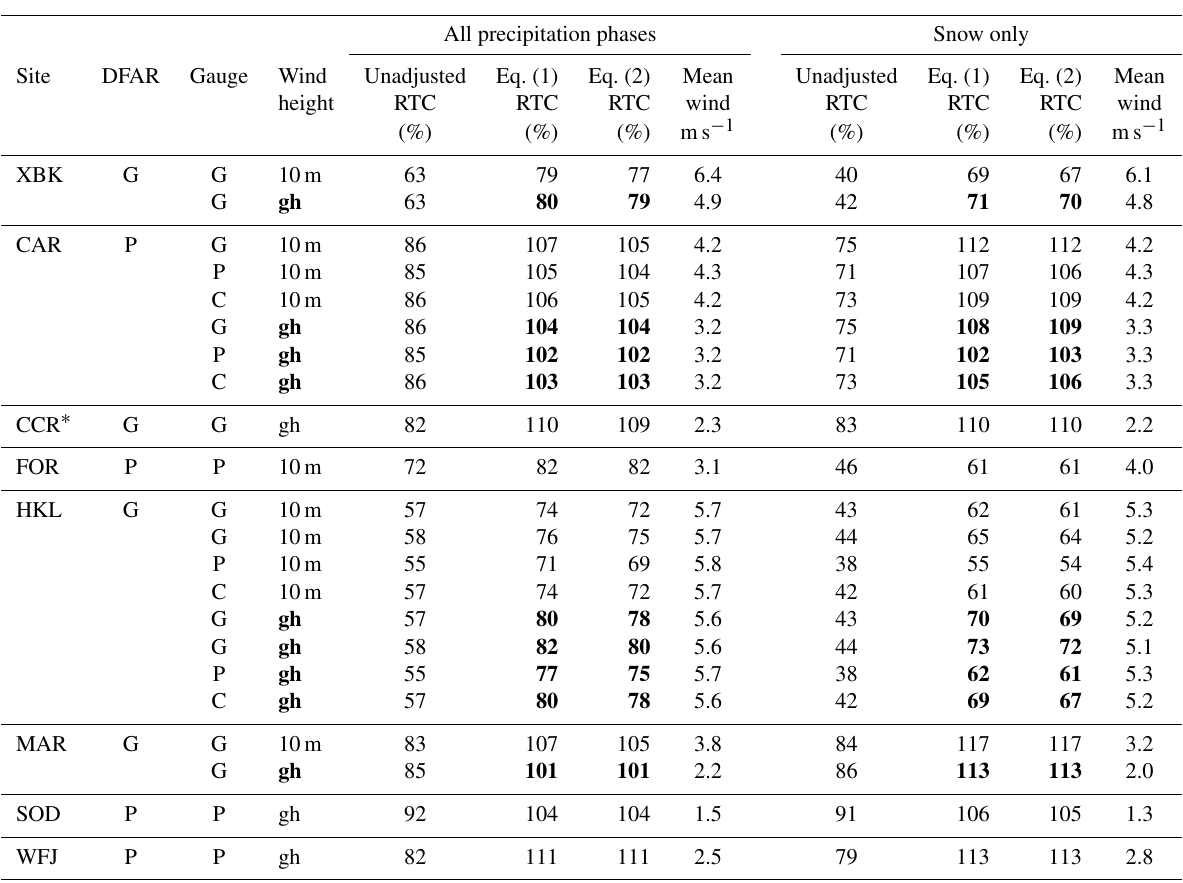
Table 2. Relative total catch (RTC) for the single Alter-shielded gauges (G – Geonor; P – Pluvio 2 ) as compared to the DFAR reference at each site for the combined winters of 2015/2016 and 2016/2017. Results are provided for available wind speed measurement heights (10m; gh – gauge height) and for Eqs. (1) and (2). Metrics are separated by precipitation phase (all and snow only). Where both wind speed heights are available, the gauge height data are shown in